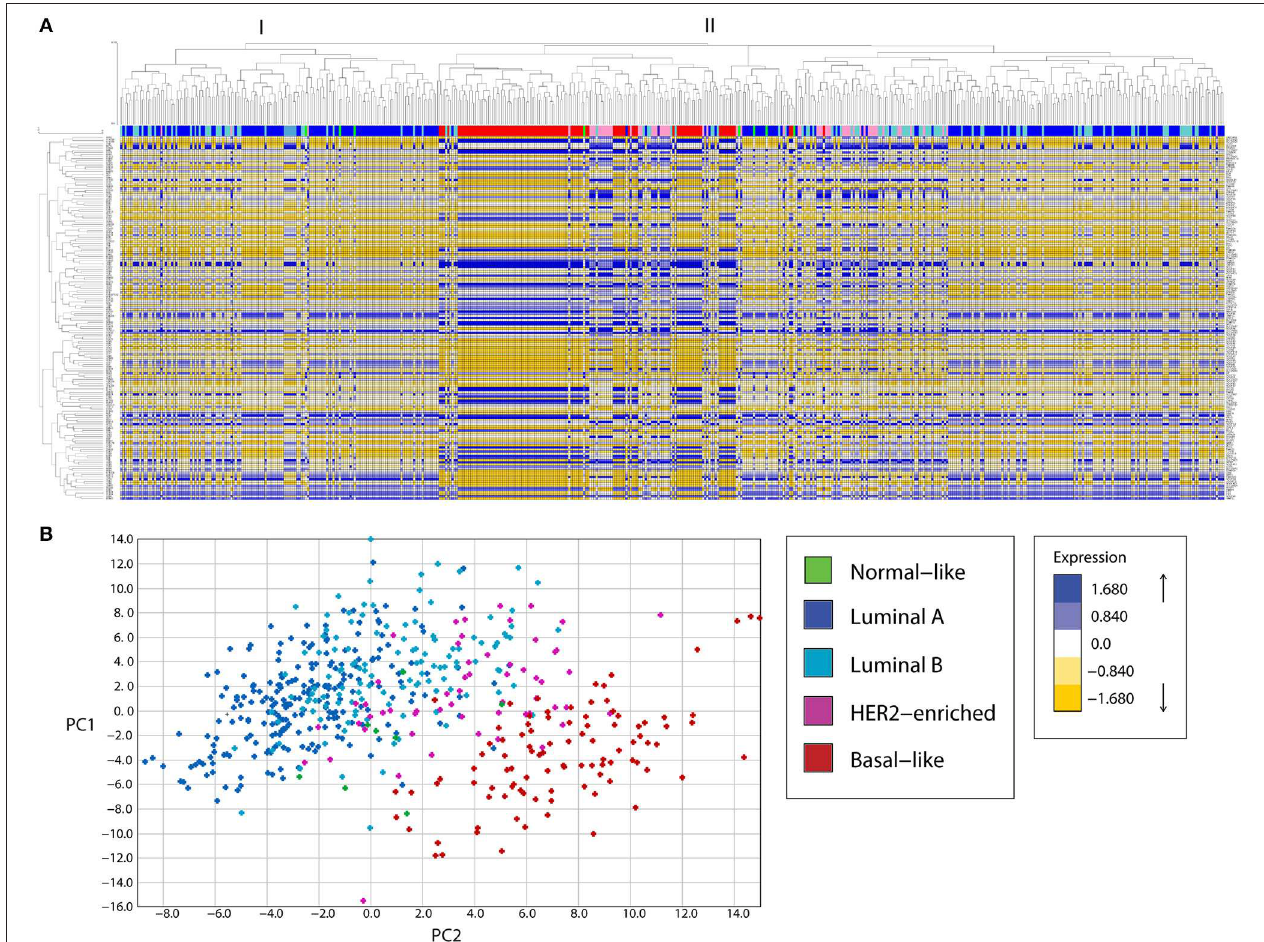
FIGURE 1 | A mitochondria-related gene signature separates breast cancer tumor samples in clusters according to the tumor subtype, in a bioinformatic analysis of gene expression. (A) A mitochondria-related gene expression signature was analyzed in TCGA breast tumor samples using unsupervised hierarchical clustering analysis, revealing clusters of samples enriched in molecular subtypes. Two major clusters were found (I, II). Cluster I was enriched in luminal samples while cluster II showed two major sub-groups. The first subgroup was enriched in basal and HER-2 enriched samples while the other was heterogeneous with one sub-group enriched in luminal samples and another containing luminal B and HER2-enriched tumors. (B) Principal component analysis (PCA) revealed three main clusters, a cluster of Luminal A and B tumors (left), an intermediate group composed of HER2-enriched and some Luminal B samples and a Basal-like enriched cluster (right). PC, principal